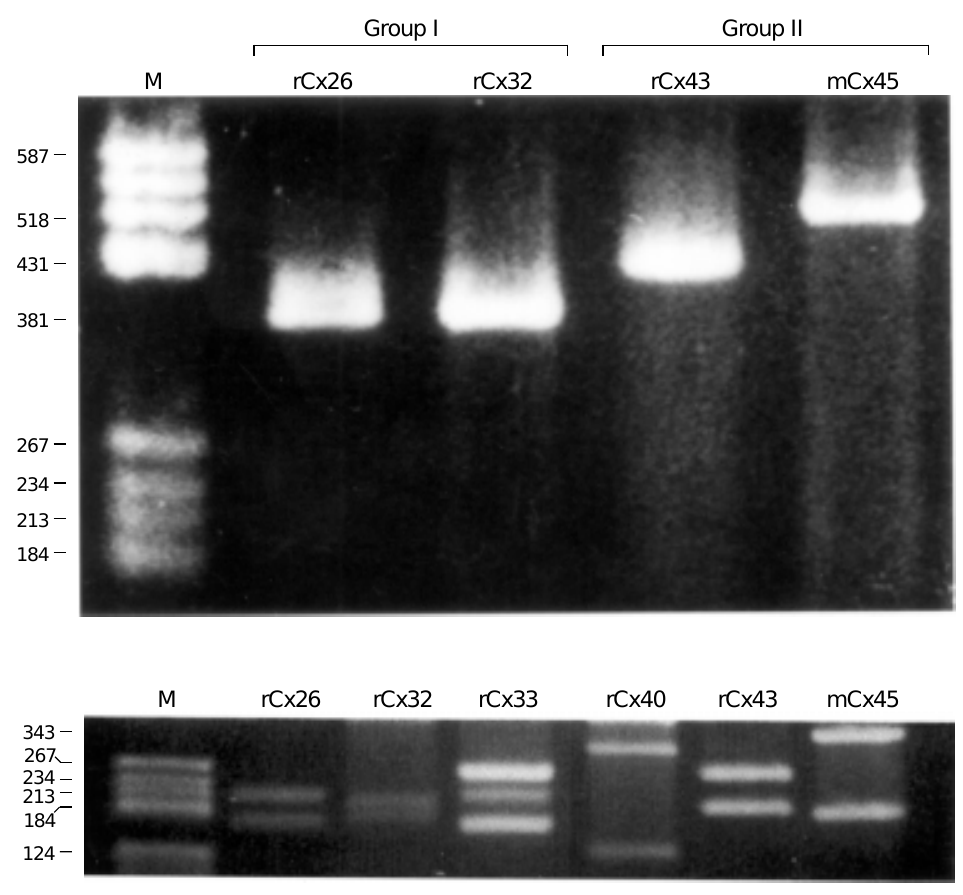
Figure 2 - Digestion of PCR prod- ucts of clonned connexin cDNAs by specific endonucleases.